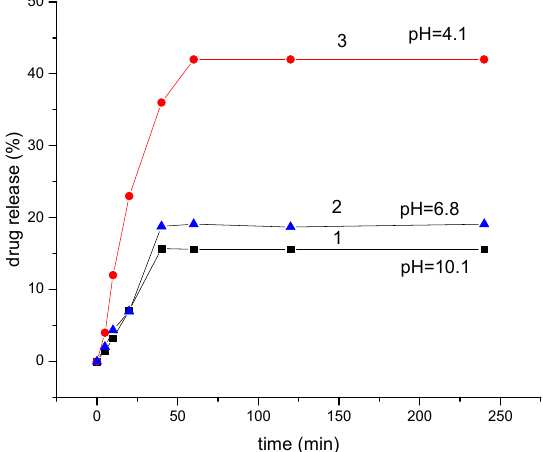
Figure 9. Release of NAP from the NL004 at pH 10.1 (1), 6.8 (2) and 4.1 (3) assessed by fluorescence measurements under excitation at 259 nm.